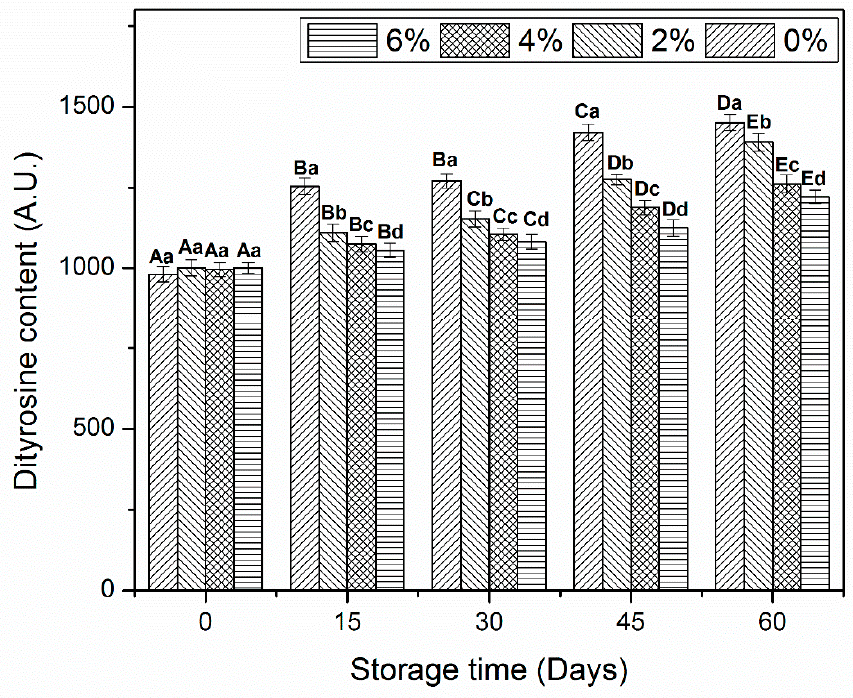
Figure 4. Dityrosine contents of myofibrillar protein treated with different concentrations of OVA-KC during 60 days of frozen storage at − 18 ◦ C. Capital letters (A–E) refer to the significant differences in similar treatments within the different storage times ( p < 0.05). Lowercase letters (a–d) refers to the significant difference in the same frozen storage period of different concentrations ( p < 0.05).